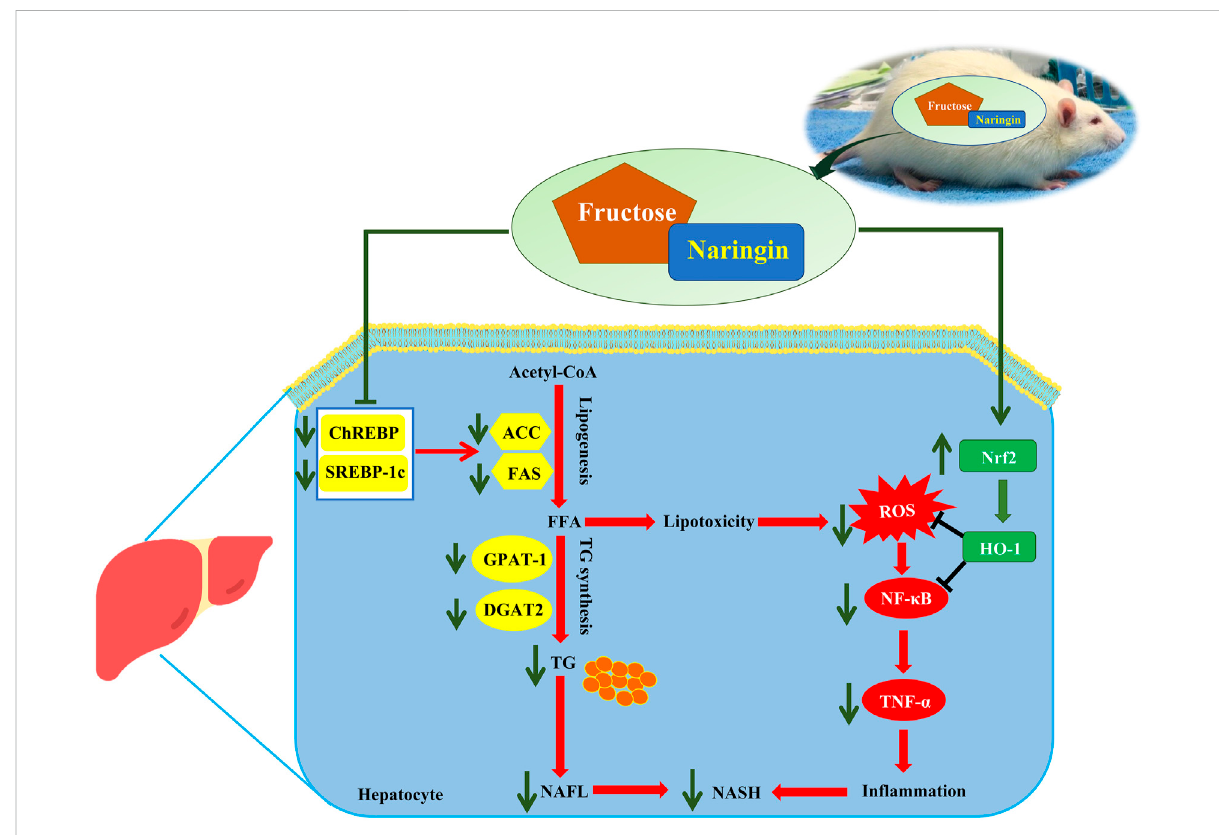
FIGURE 6 Schematic diagram of the possible mechanism of naringin in fructose-induced fatty liver disease.